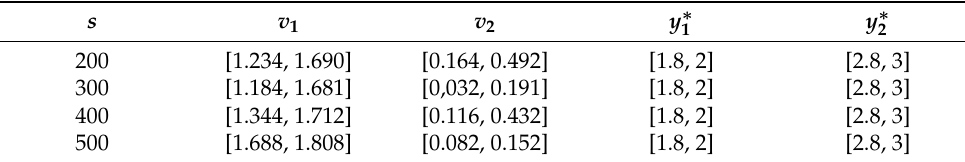
Table 1. The results of control for various values of the